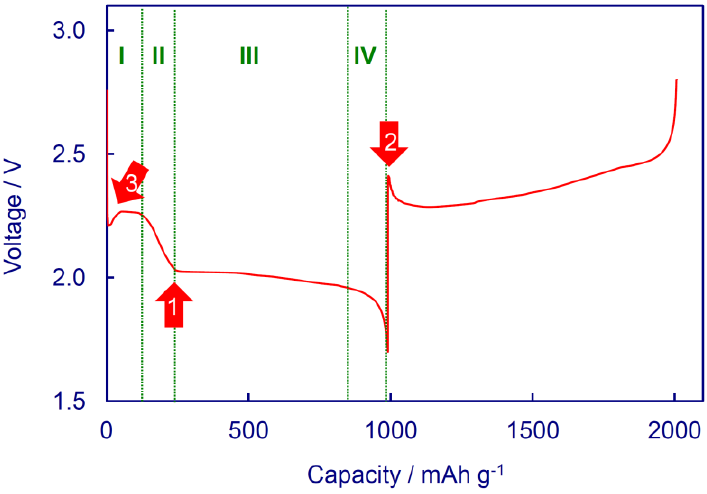
Figure 4. Discharge and charge voltages of the first cycle for a Li/S cell with an E/S ratio of ~10 mL g −1